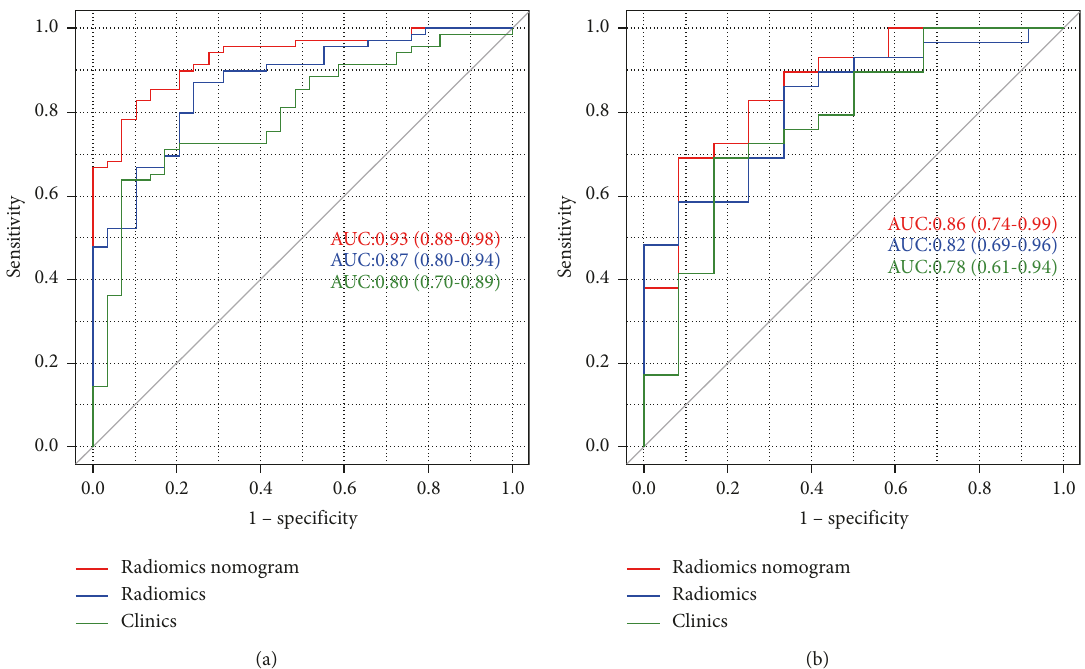
Figure 3: The area under receiver operator curve (AUROC) of the training group (a) and test group (b).